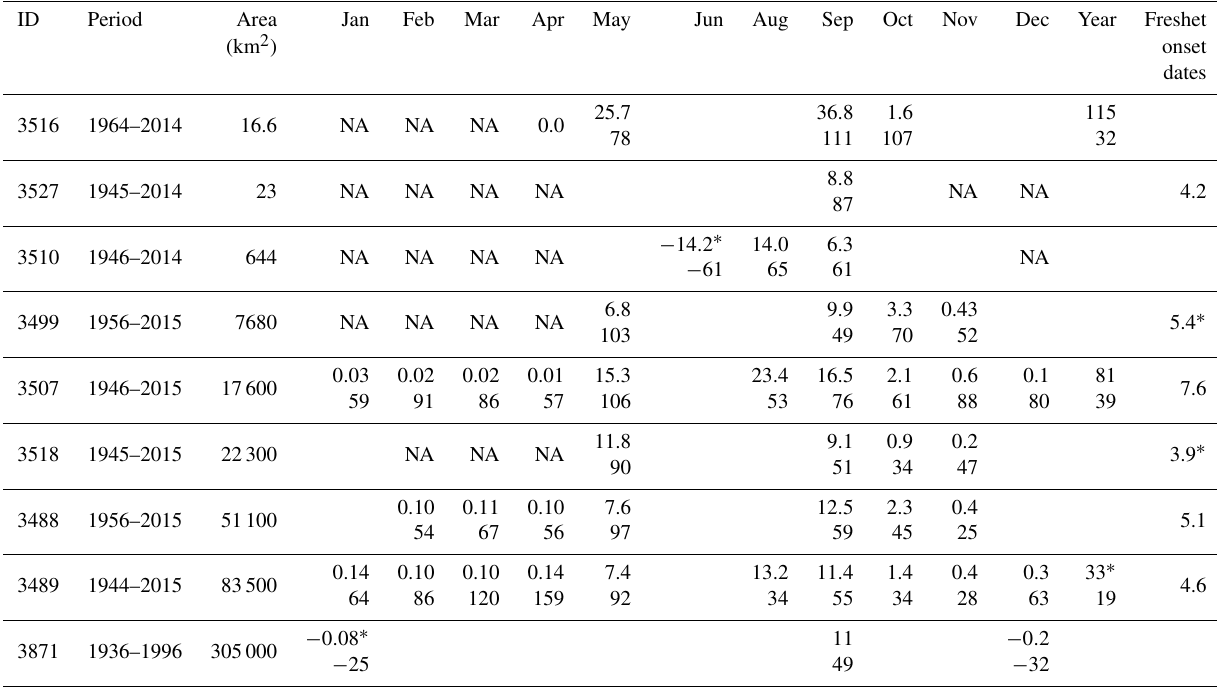
Table 8. Changes in monthly and annual streamflow (millimeters and percent) and freshet onset dates for the Indigirka River basin. ID Period